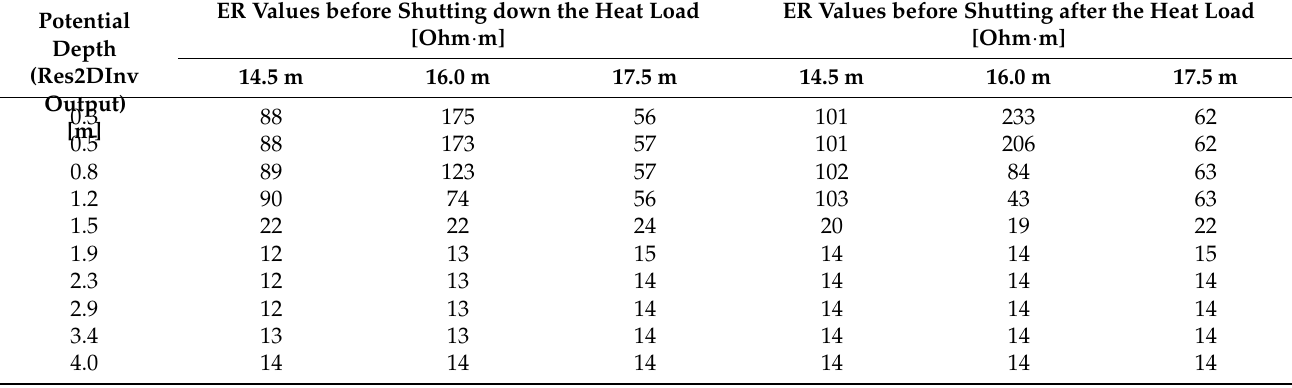
Table 1. The exact electrical resistivity (ER) values of the respective fifth iteration of the inversion process of both ERT measurements (before and after shutting down the heat load) directly at the helical BHE position at 16 and 1.5 m before and behind this position (at 14.5 and 17.5 m) for the first 4 m of